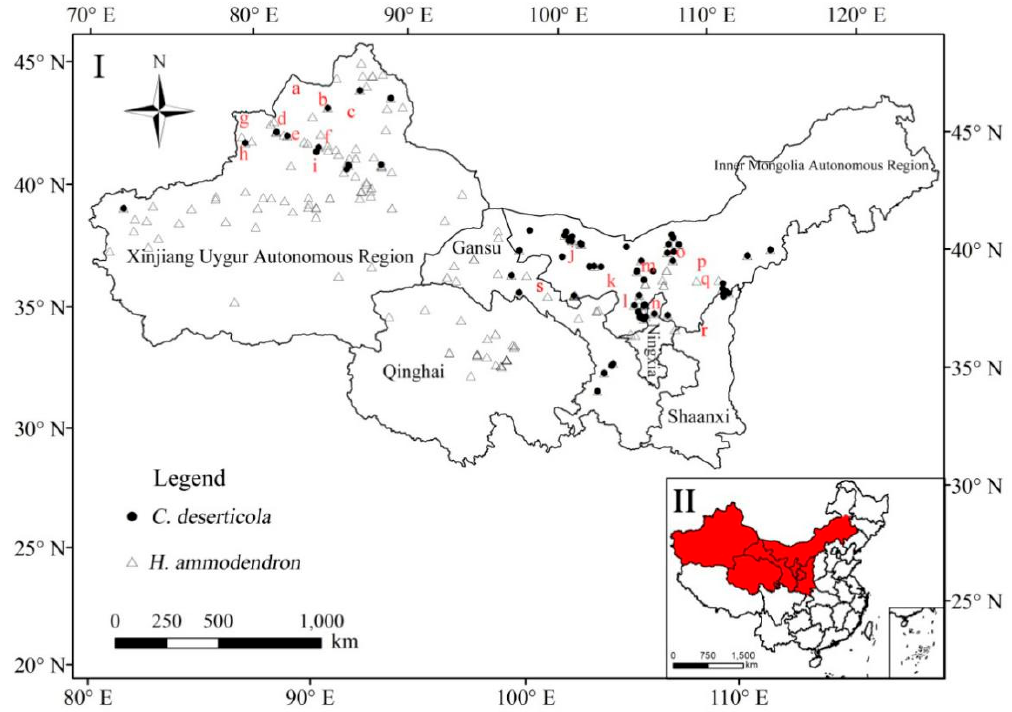
Figure 2. Geographic locations of C. deserticola and H. ammodendron , the black dots are the sampling points of C. deserticola , and the triangles are H. ammodendron . ( I ) study area; ( II ) study area in China. The red letters represent the counties and topographical units involved in study area. ( a ) Tacheng City; ( b ) Junggar Basin; ( c ) Hoboksar; Tacheng City; ( d ) Alashankou city; ( e ) Wusu city; ( f )